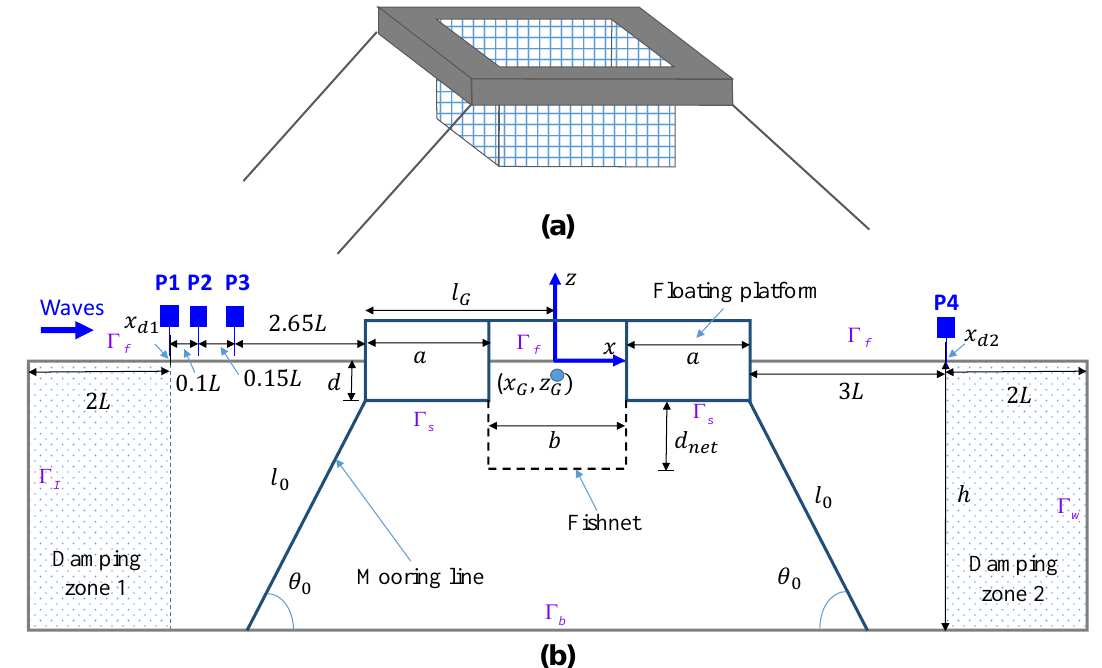
Figure 1. ( a ) The concept design and ( b ) definition sketch of the floating platform with a fishnet in a numerical wave tank.